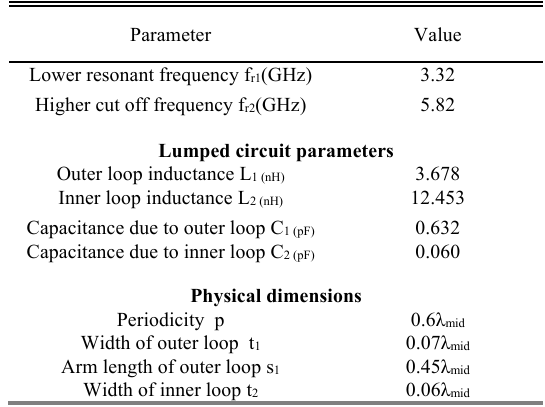
TABLE I. Parameters of DSLFSS in sub-6 GHz range.